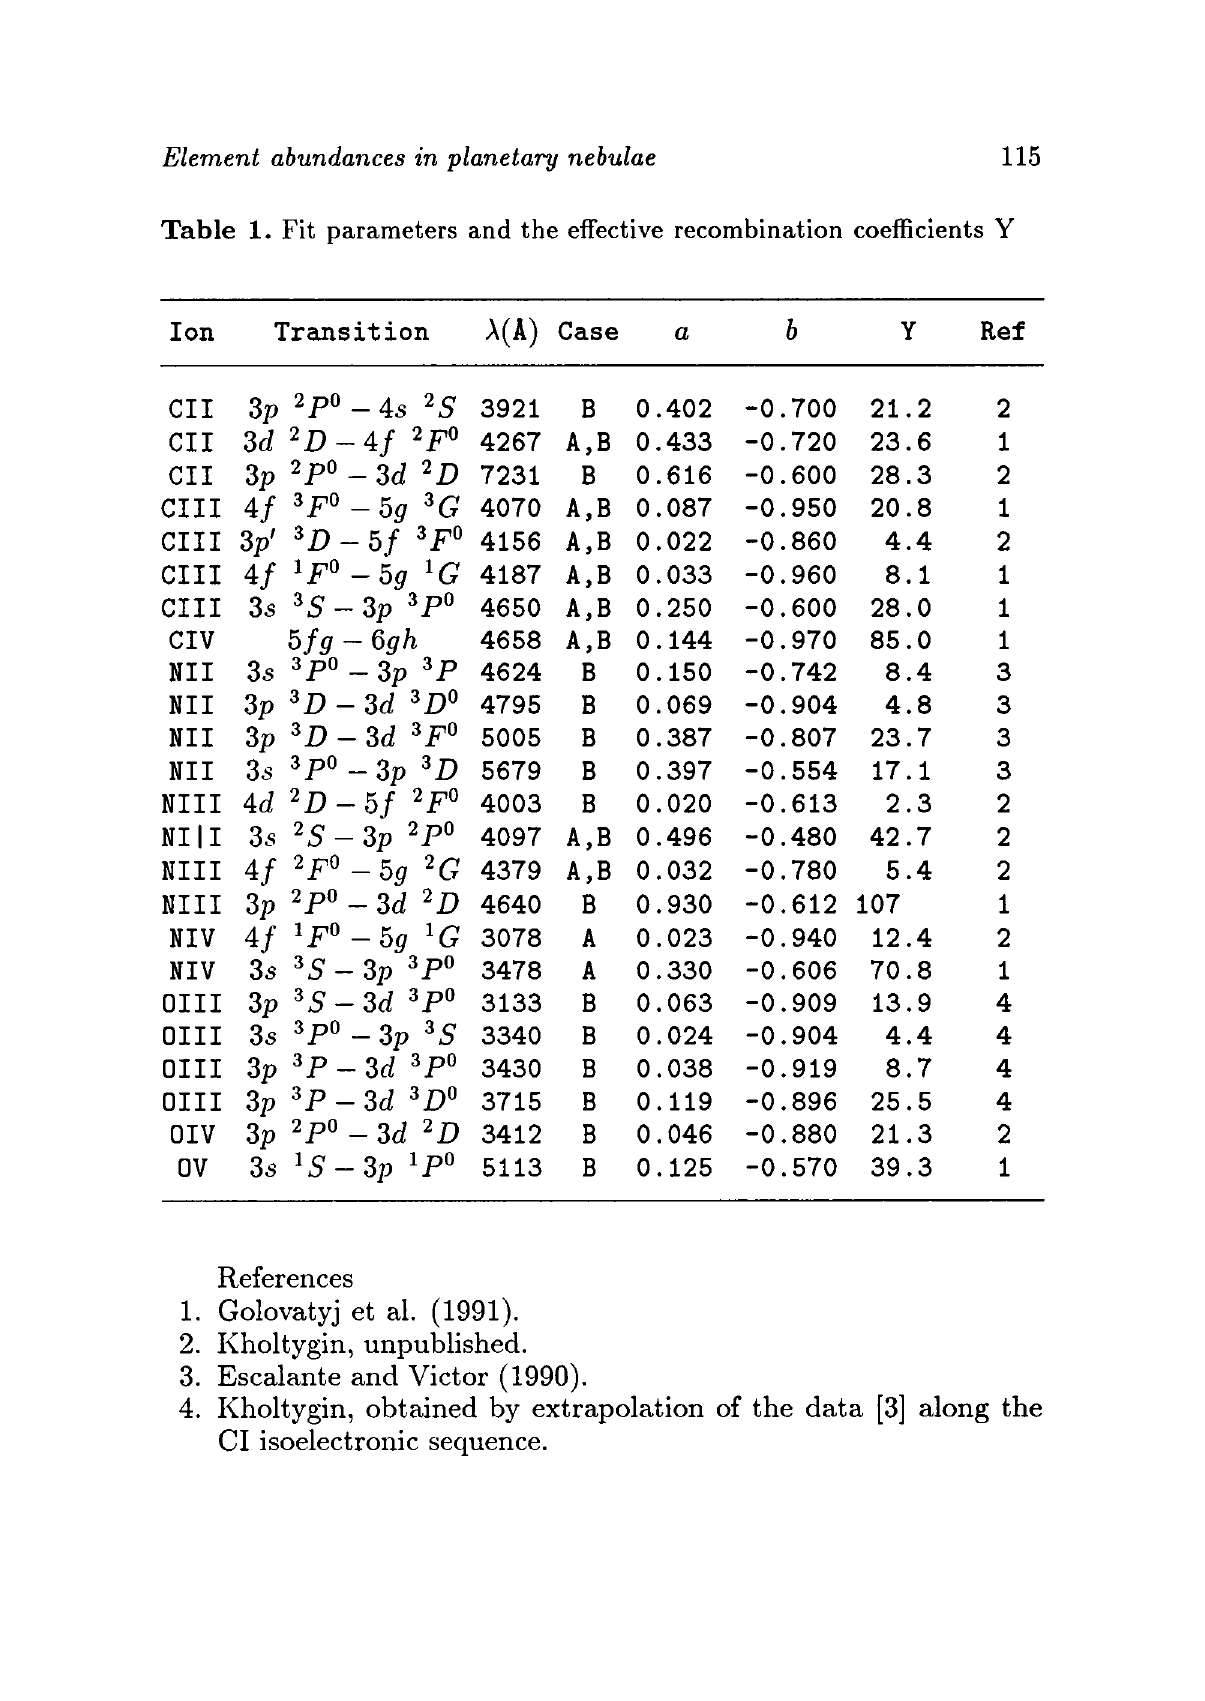
Table 1. Fit parameters and the effective recombination coefficients